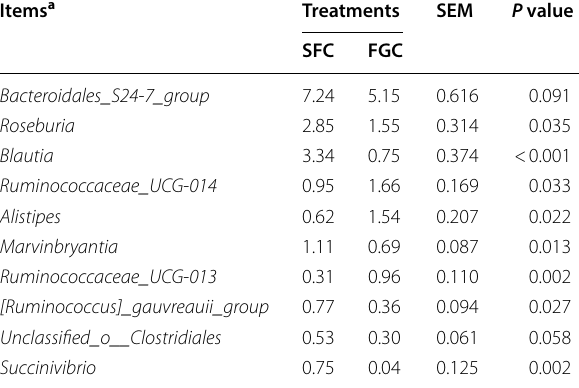
Table 3 Percent relative abundance of genera with a significant effect of diet with steam flaked corn (SFC) or finely ground corn (FGC)